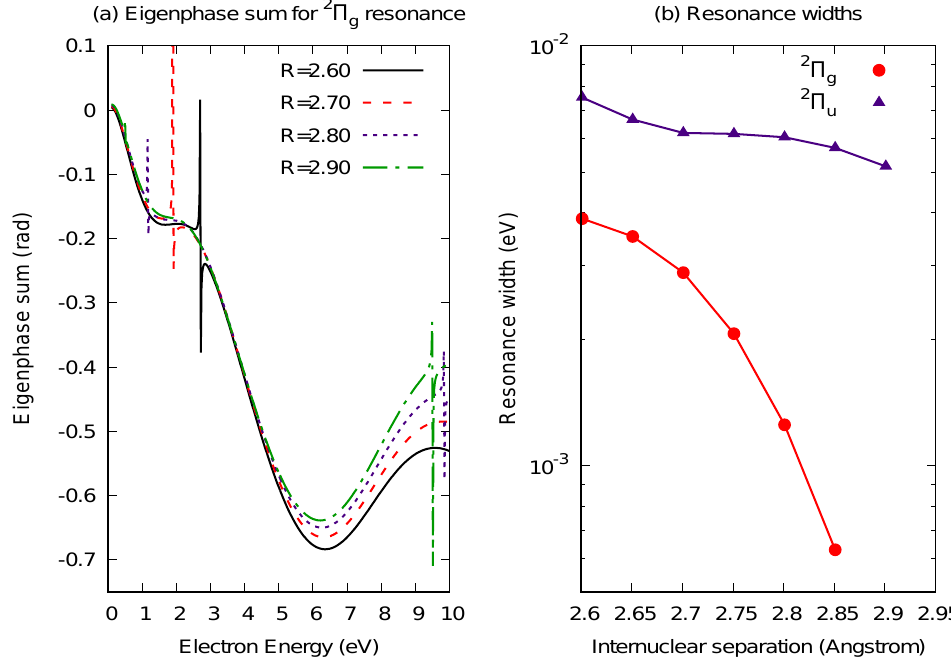
Figure 4. ( a ) Eigenphase sum for the 2 Π g symmetry evaluated at several internuclear separations R . ( b ) Resonance widths Γ ( R ) for the two scattering symmetries considered in the present